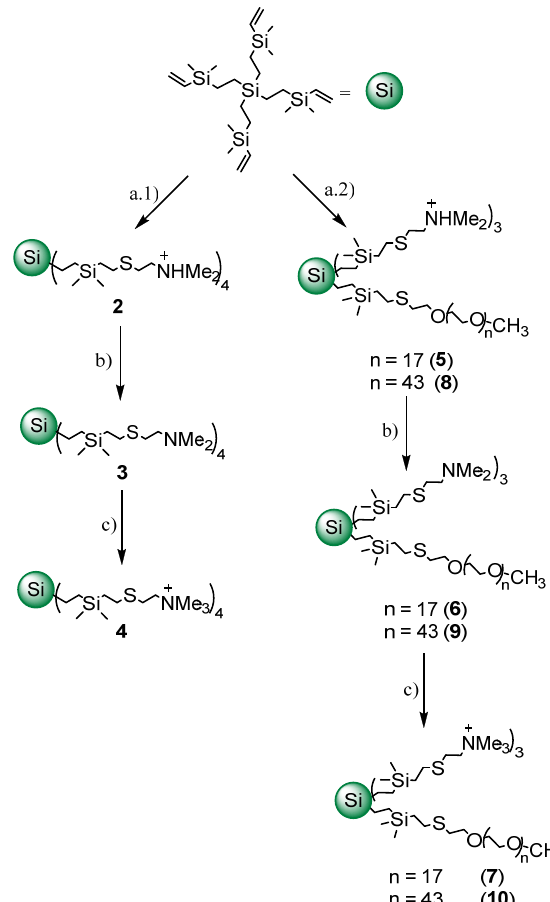
Figure 1. Synthesis of unPEGylated and PEGylated cationic CBS dendrimers. Experimental condi- tions: ( a.1 ) 5% DMPA, h ν , THF/MeOH (1:2), HSCH 2 CH 2 NH 2 ·HCl (4 equiv.), 4 h; ( a.2 ) 5% DMPA, h ν , THF/MeOH (1:2), HS-PEG800 or HS-PEG2K (1 equiv.) for 30 min, then HSCH 2 CH 2 NH 2 ·HCl (3 equiv.) 4 h; ( b ) excess of NaHCO 3 , distilled H 2 O, 1 h; ( c ) excess MeI, dry THF, 16 h.